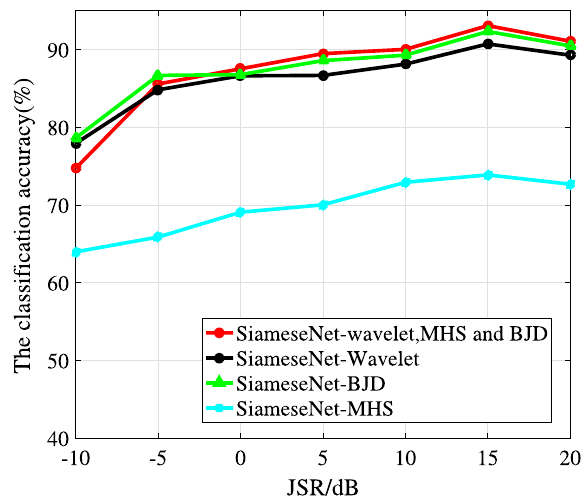
Fig. 9 Classification accuracy of different time-frequency analysis methods versus